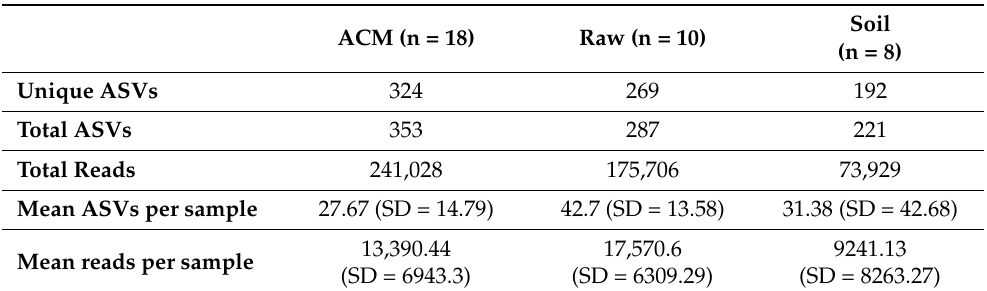
Table 1. Summary of ASV and read numbers, post-processing, for each sample type within the ITS